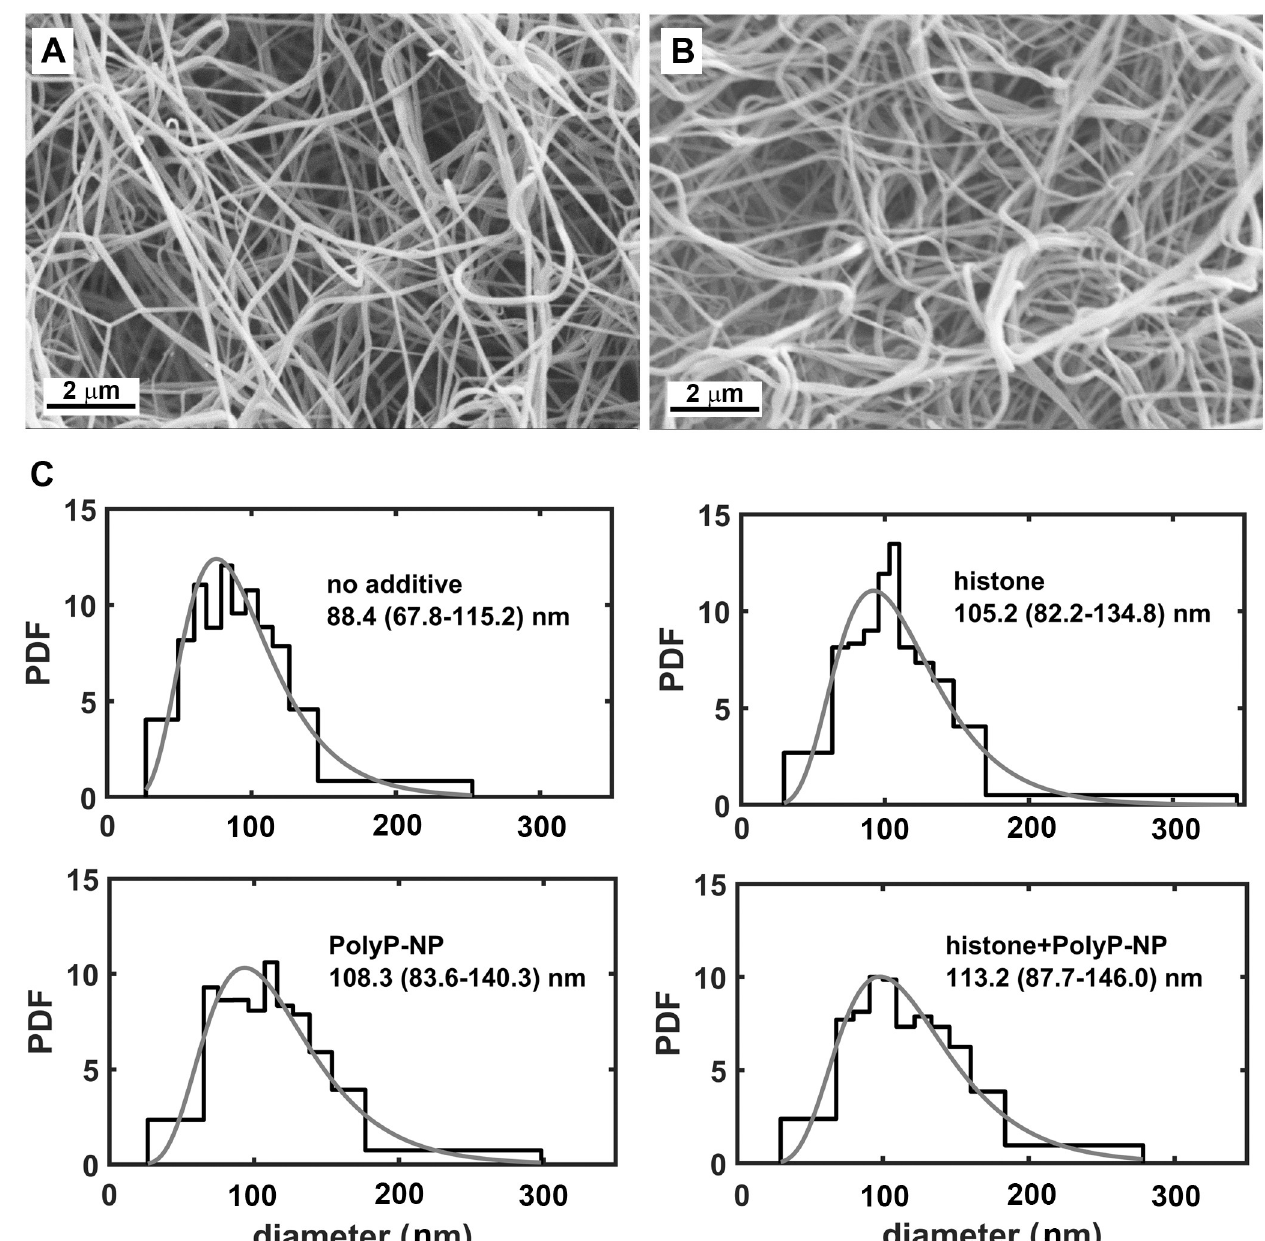
Fig 6. Effects of histone and PolyP-NP on clot structure. Representative scanning electron micrographs of fibrin prepared in the absence ( panel A ) or presence of modulators (histone+PolyP-NP ( panel B ), histone or PolyP-NP) as described in Materials and methods. Panel C: The diameters of 300 fibrin fibers were measured from each of 3 independent fibrin sample images and the probability density function (PDF) of the diameter values is shown. The empirical data are shown as a histogram with bins of equal area (each bin has equal product of density and span of data), whereas the grey line indicates the lognormal theoretical distribution that fitted best these data. All differences in the median fiber diameters were significant at p < 0.05, according to Kuipers’s test of the distributions [20].